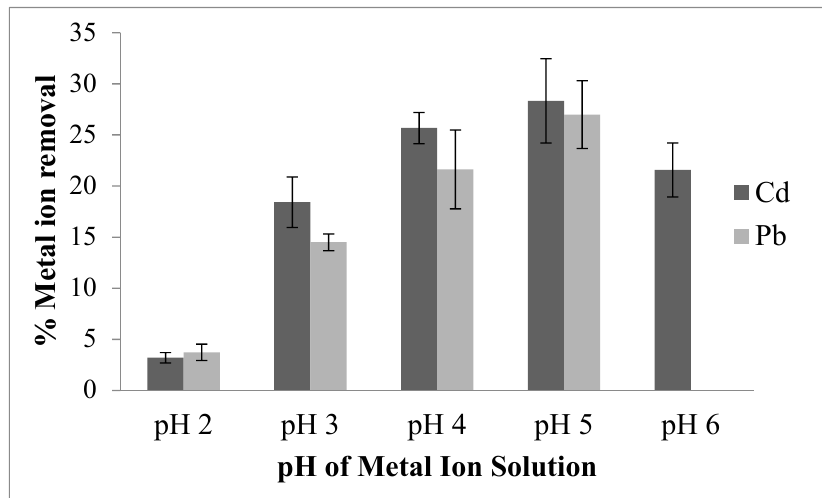
Figure 5. Effect of solution pH on metal ion removal (mean ± RSD) (50 mL, 50 ppm) using powdered biomass (0.1 g, 0.212–0.5 mm) (120 rpm, 60 min, 25 °C). Each measurement was done in triplicate.